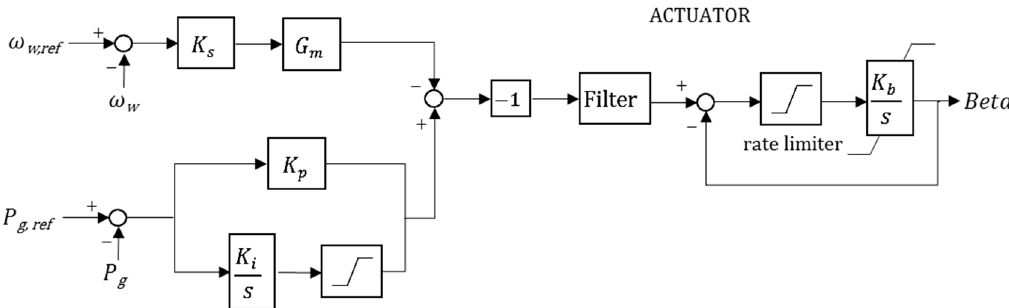
Figure 4. Wind governor transfer function.